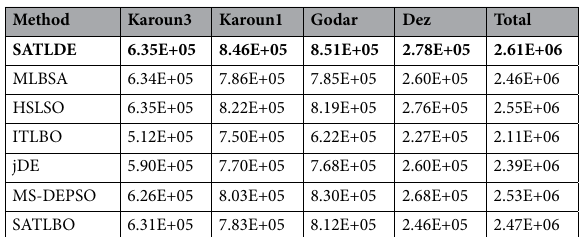
Table 5. Results of SATLDE algorithm and six other optimizers for real world multi-reservoir system. Significant values are in bold.